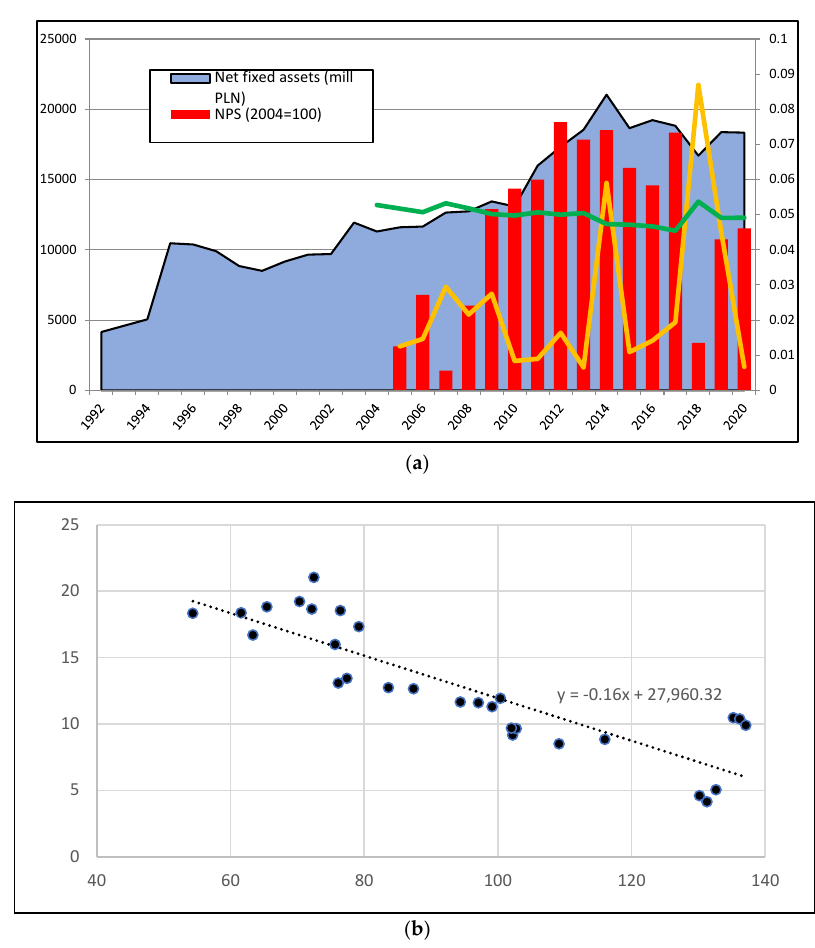
Figure 8. Net fixed assets in coal mining companies in Poland in 1992 – 2020; ( a ) Net fixed assets in 1992 – 2020, intensity of structure changes (NPS 2004 = 100, NPS y/y), and concentration (HHI) in 2004 – 2020; ( b ) The regression curve of the net fixed assets and the hard coal output in Poland in 1992 – 2020. Notes: net fixed assets — left axis. Remaining remarks as to Figure 5. Source: as in Figure 5.